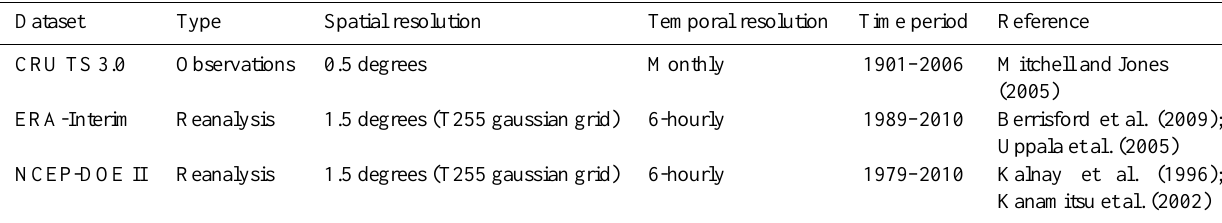
Table 1. Spatial and temporal characteristics for the climate forcing